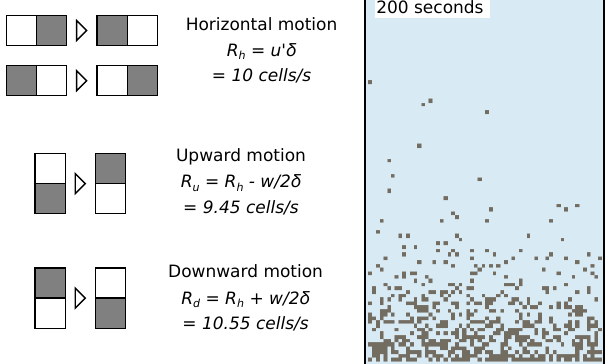
Figure 2. Turbulent suspension model with grains (1mm tea leaves) that are 0.2% denser than the surrounding fluid. Left: illustration of cell-pair transitions representing motion in the four directions. Grain settling velocity of 0.0011ms − 1 imparts asymmetry to the transition